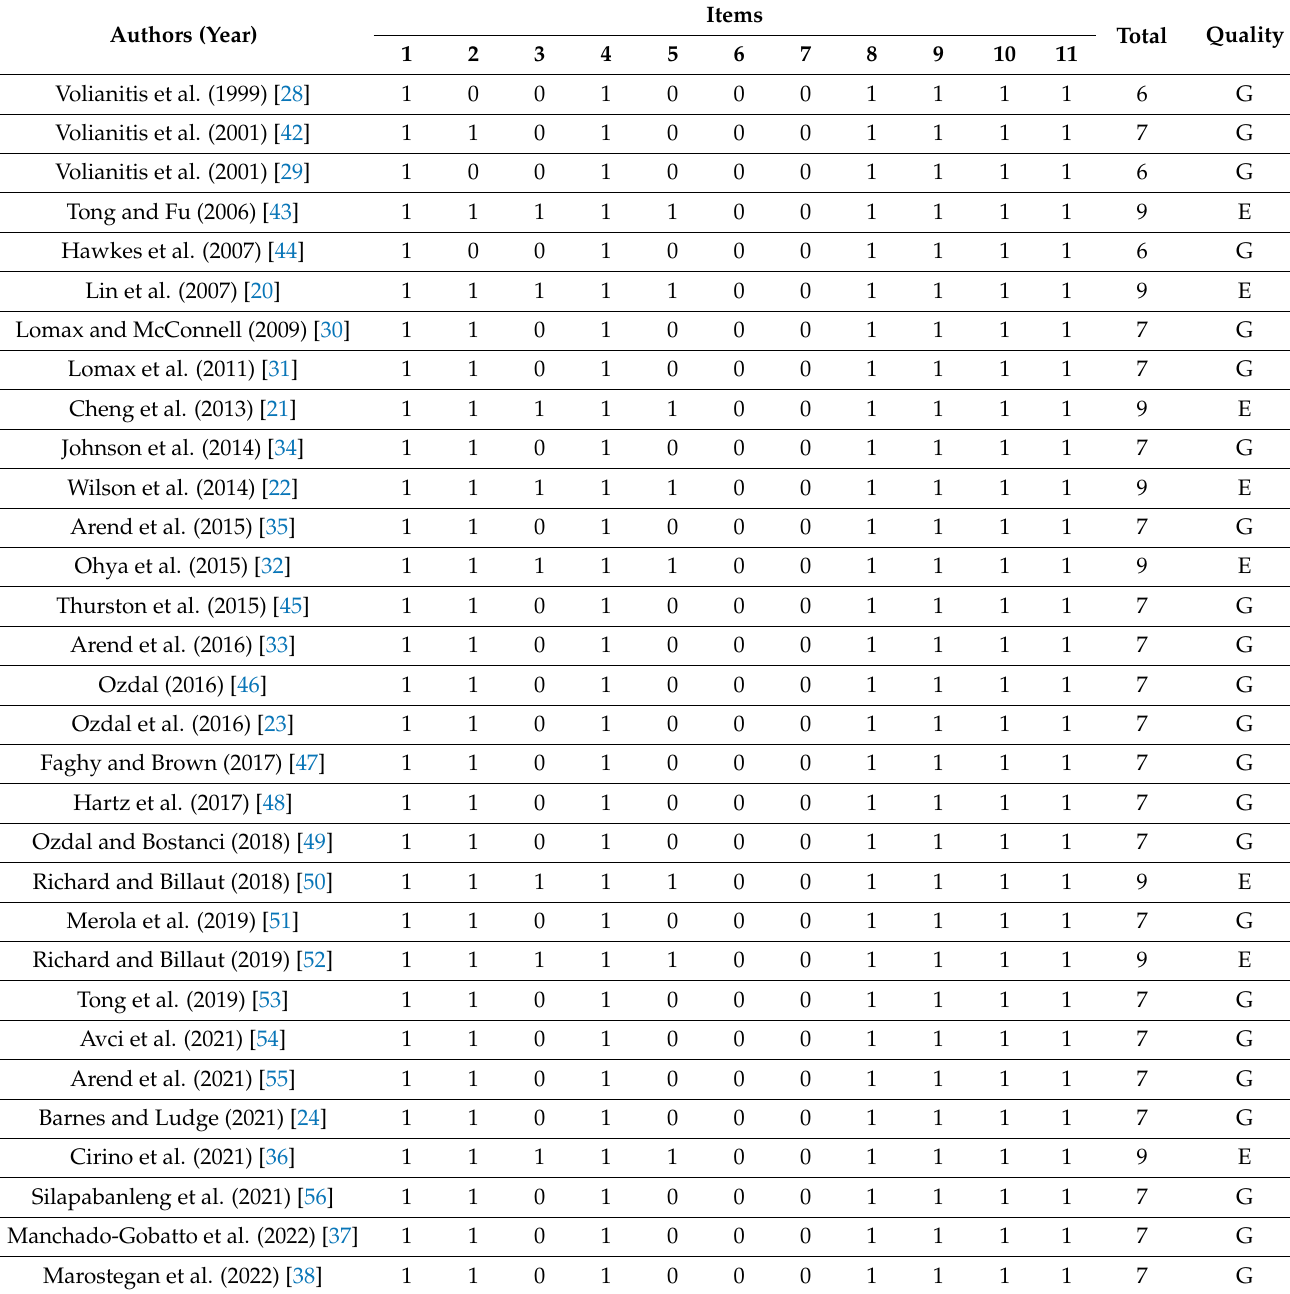
Table 2. Assessment of the methodological quality of studies (PEDro